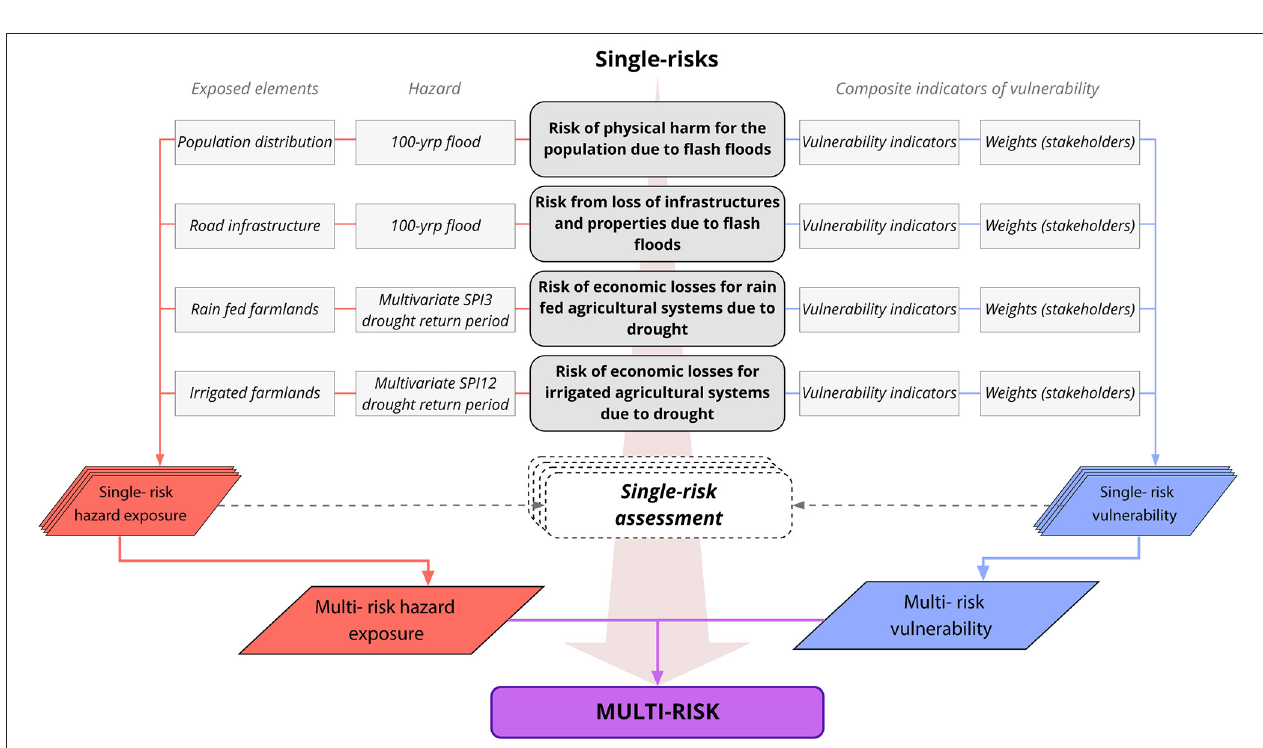
FIGURE 3 | Operationalization of multi-risk assessment for the current study.